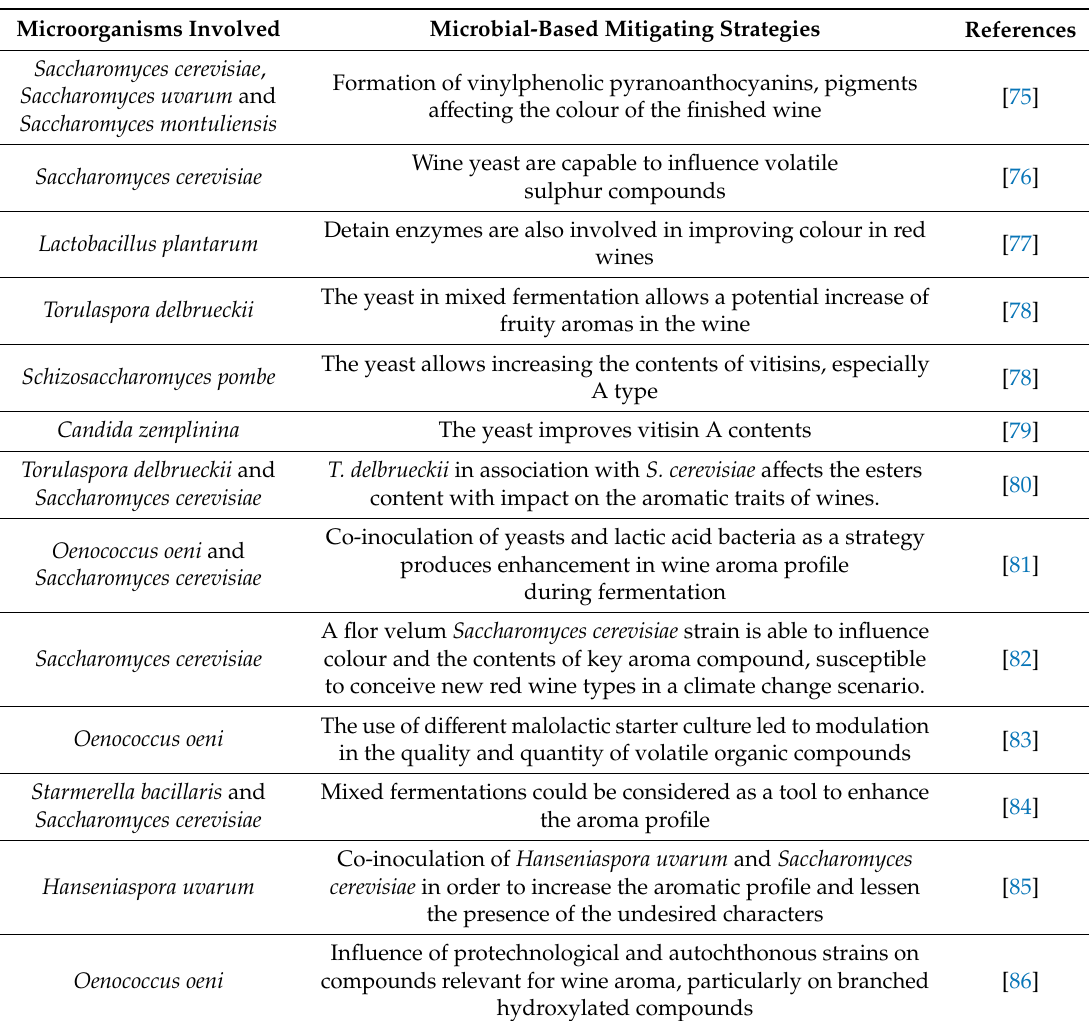
Table 5. A list of studies that propose microbial-based solutions that have potential applications in mitigating modifications of sensory